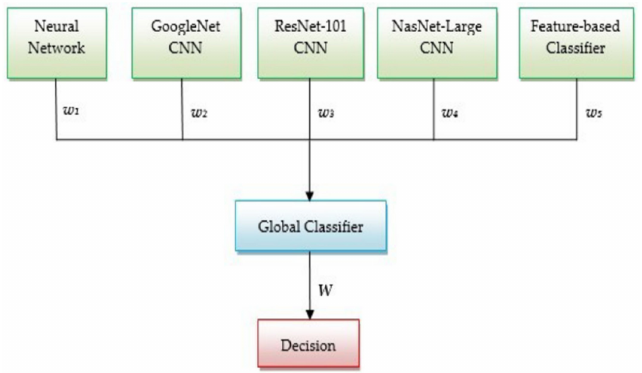
Figure 26. Multi-network system architecture based on decision fusion for Me detection